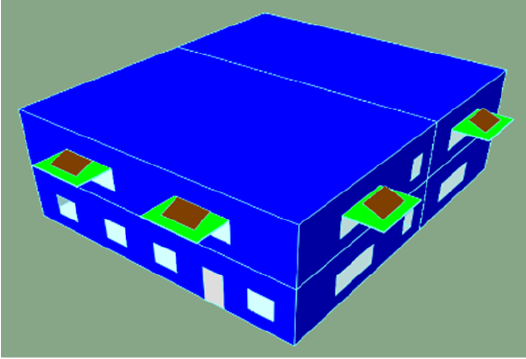
Figure 8. Arrangement of PV ‐ integrated shading devices.